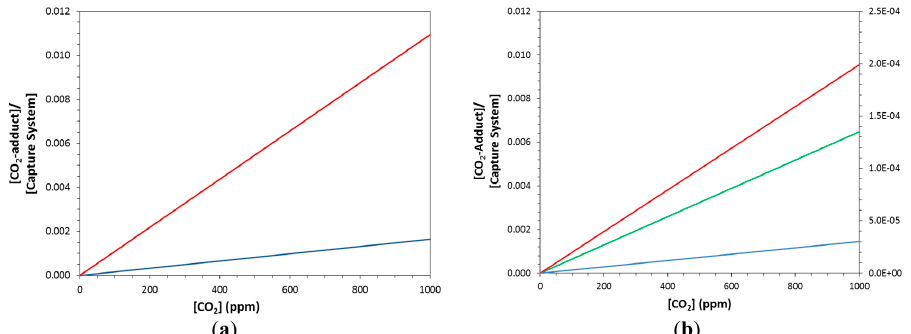
functions are as follows: ( a ) Blue; y = 3.91 × 10 -4 x, Red; y = 2.30·× 10 -3 x; ( b ) Blue; y = 7.05 × 10 -6 x, Red; y = 4.15 × 10 -5 x, Green; y = 2.42 × 10 -3 x.